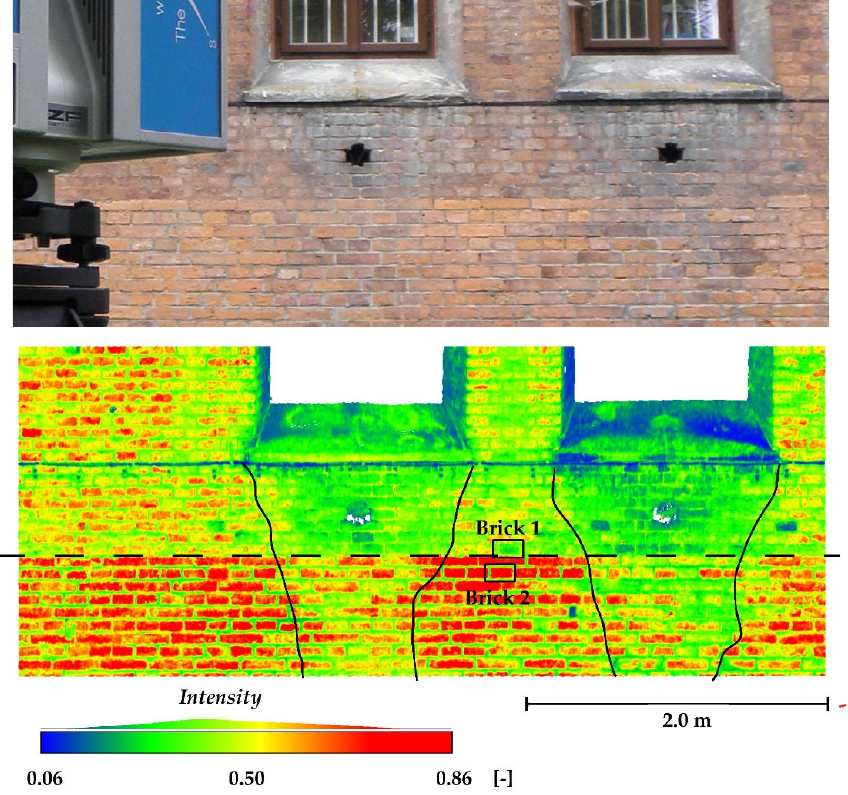
Figure 8. Detection of different types of bricks and places which are prone to saturation.